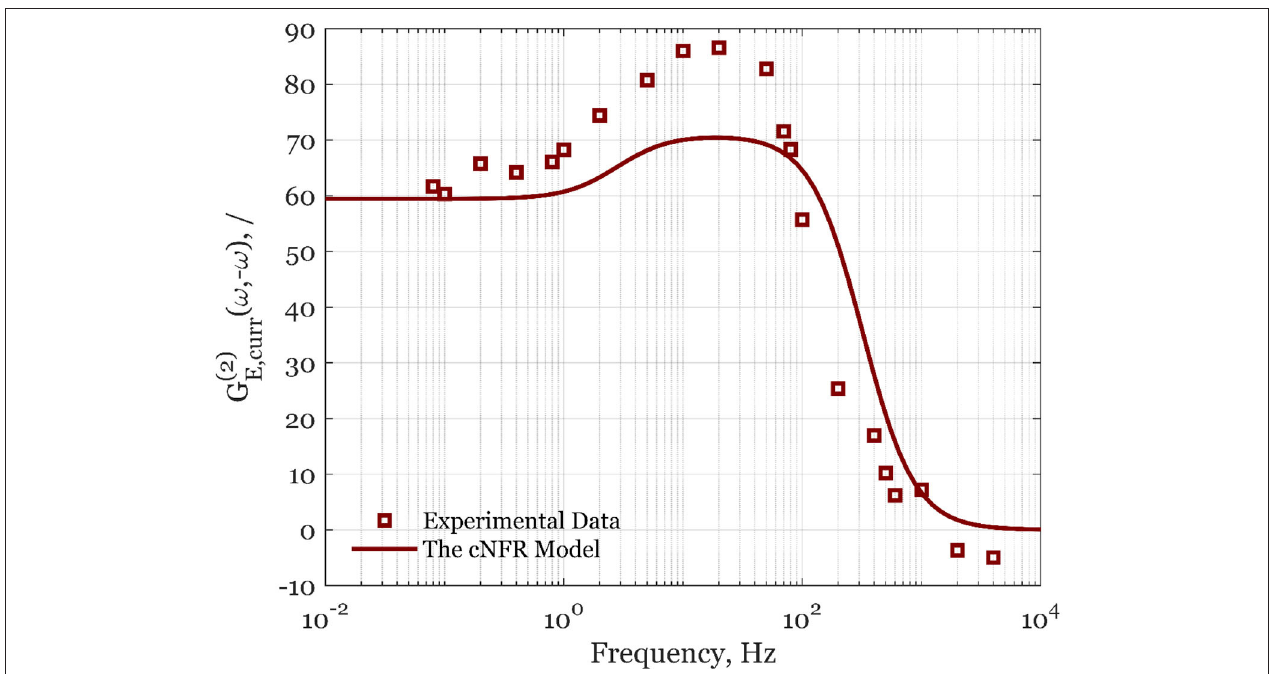
FIGURE 2 | Averaged experimental data (squares) and simulated cNFR results (line) of the second-order asymmetrical FRF for the potential, E , as the input, and current density, curr , as the output at the steady-state potential of 0.8V and 1,600